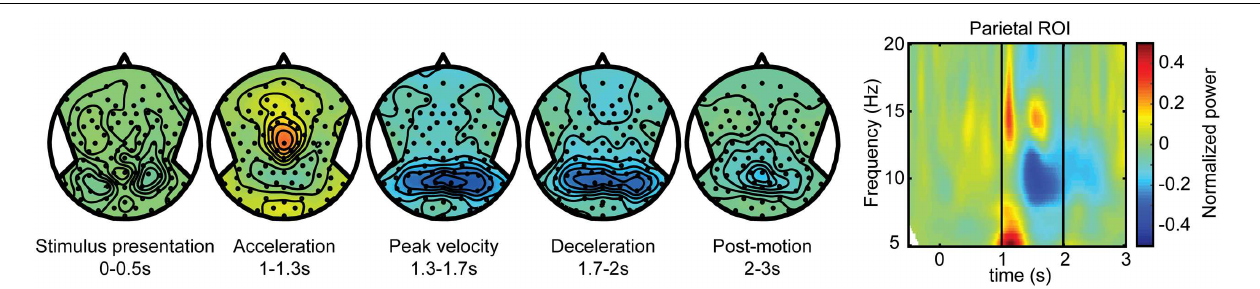
FIGURE 3 | Self-motion estimation activity. Electroencephalography (EEG) scalp topoplots (Left) of alpha-band activity for time windows before, during and after motion for the self-motion contrast. This contrast was created by using body-fixed data, averaged over all target locations, and subtracting small motion from large motion. Rightward motion was flipped across the midline and averaged with the leftward motion. This isolates activity that increases with larger motion, while subtracting out effects of target coding and constant activity. (Right) Time-frequency plot for a parieto-occipital ROI (Pz, PO3/4, POz, and PPO1/2h). Motion occurs between t = 1 and 2